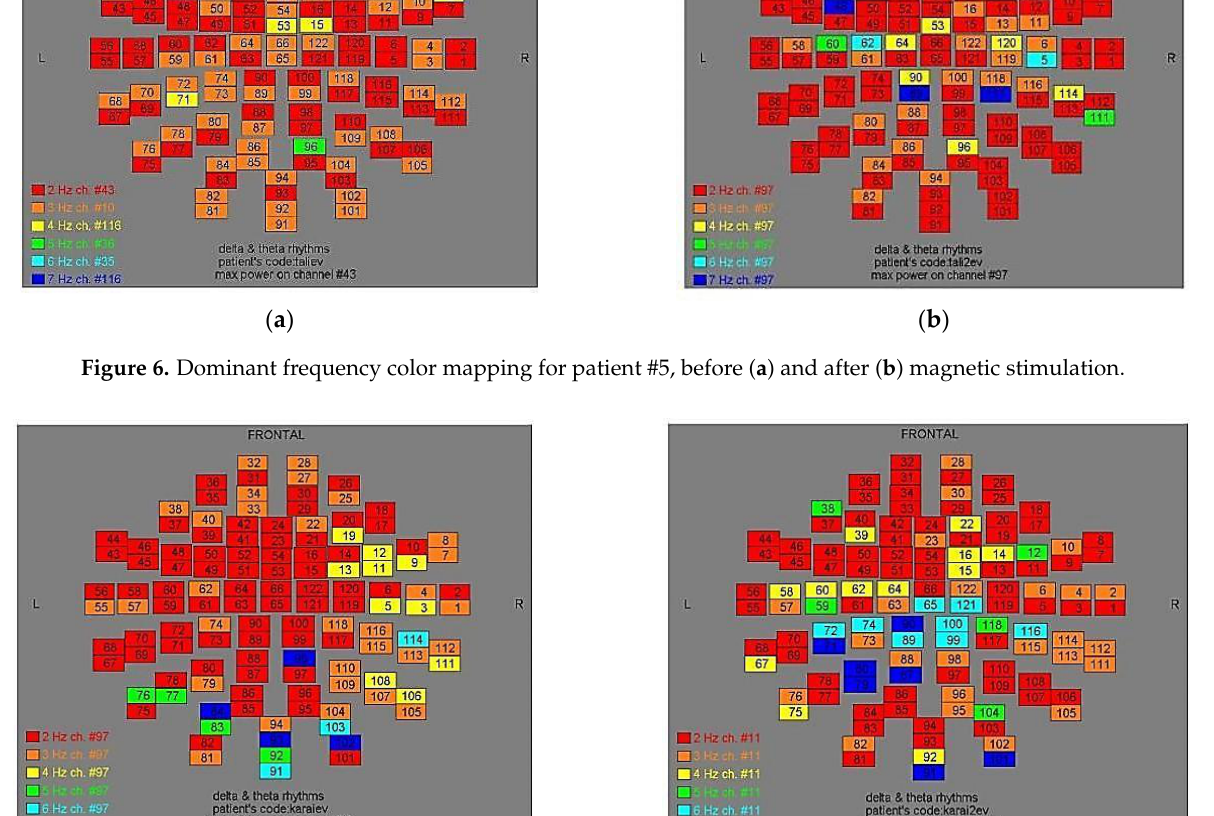
Figure 7. Dominant frequency color mapping for patient #6, before ( a ) and after ( b ) magnetic stimulation .